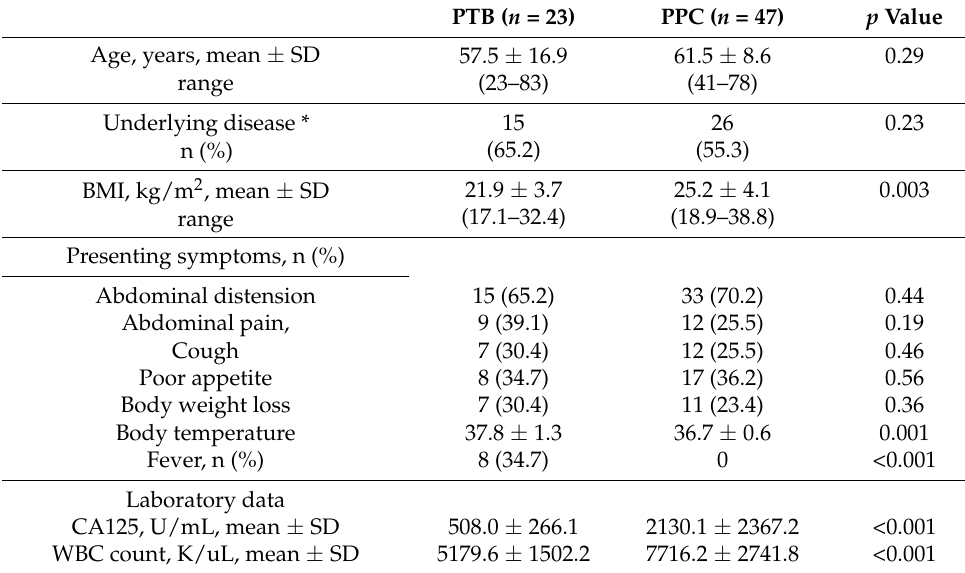
Table 1. Clinical characteristics and laboratory